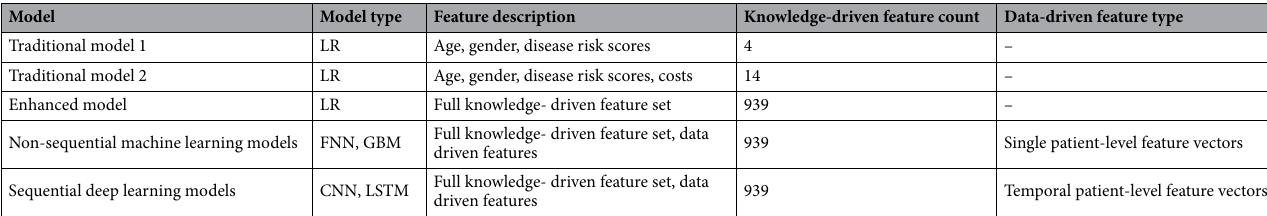
Table 1. Description of alternative traditional and enhanced risk prediction models. CNN, Convolutional Neural Network, GBM, Gradient Boosting Model; LR, Logistic Regression; LSTM, Long Short-Term